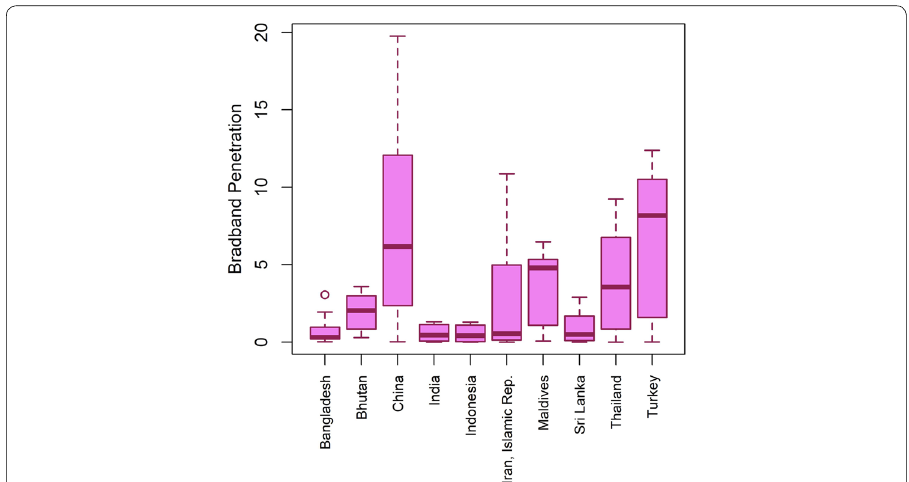
Fig. 2 Boxplot showing broadband penetration by